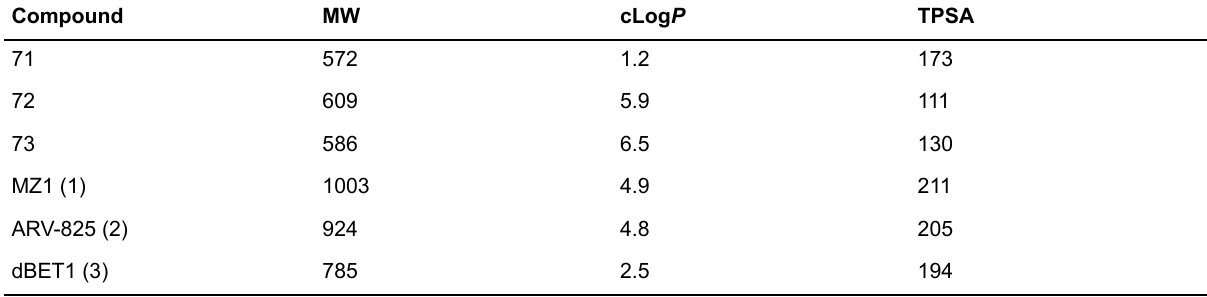
Table 2. Comparison of the physical properties of CLIPTAC precursor molecules (71-73) to published BET degraders (1-3) Compound MW cLog